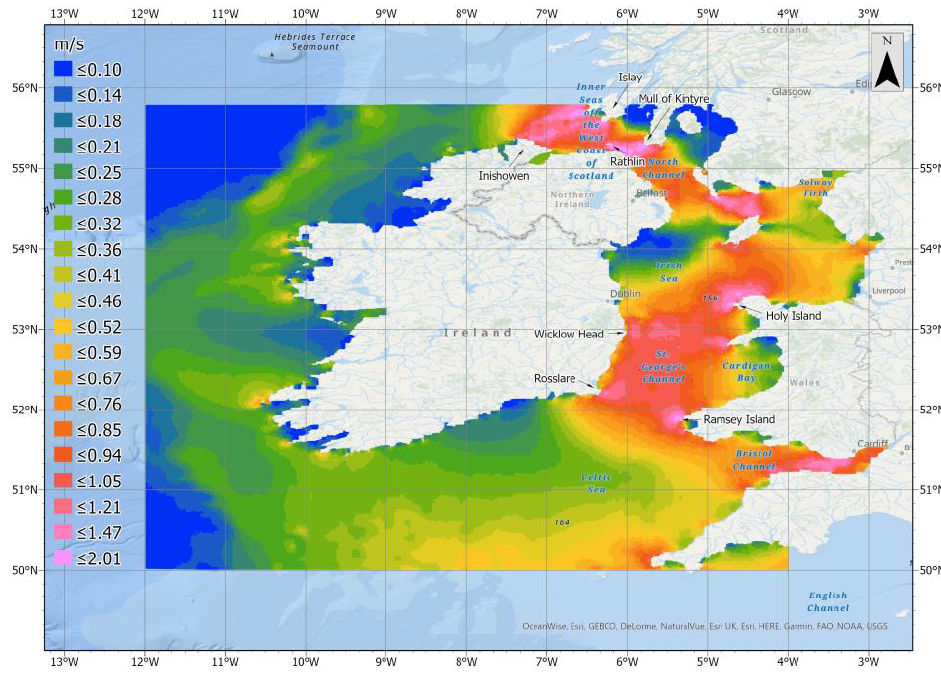
Figure 13. Mean peak current velocity on spring tides